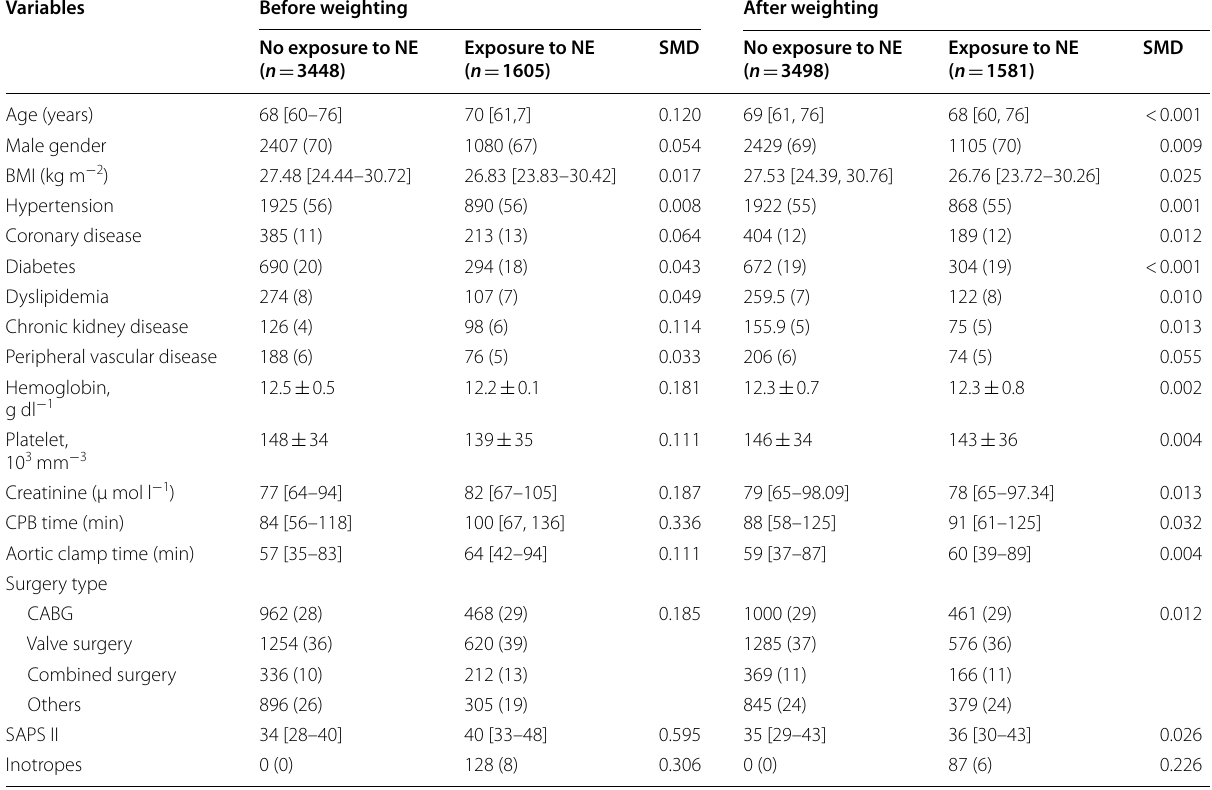
An absolute MSD < 10% was considered to support the assumption of a balance between the groups. SMD: standardized mean differences. Data are presented as medians [interquartile ranges] or as numbers (percentages). NE: norepinephrine, CABG: coronary bypass graft, CPB: coronary bypass, SAPS II: Simplified Acute Physiology Score. BMI, hypertension, and peripheral vascular disease were not selected for the propensity weighting as the P value for their association with acute kidney injury was over